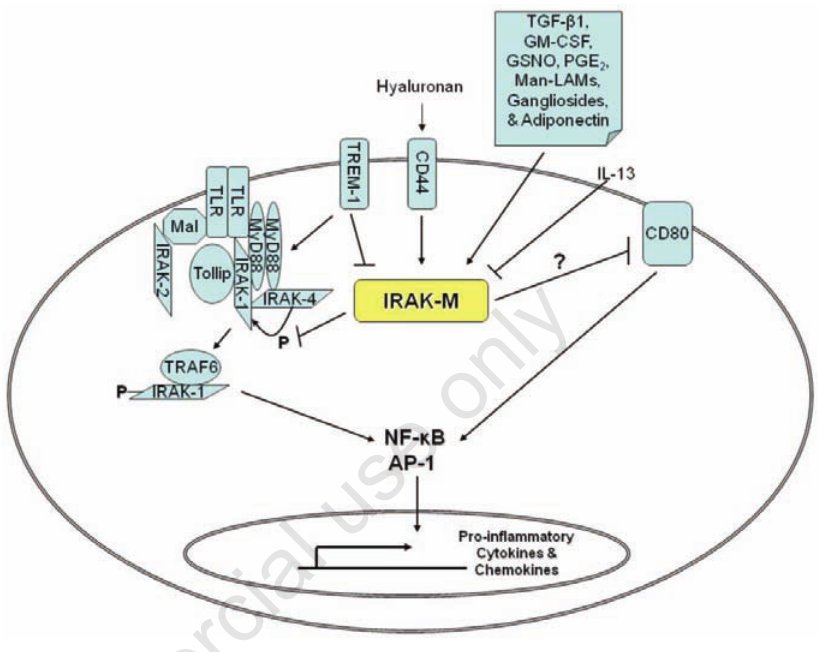
Figure 1. IRAK-M regulation and function in macrophage host